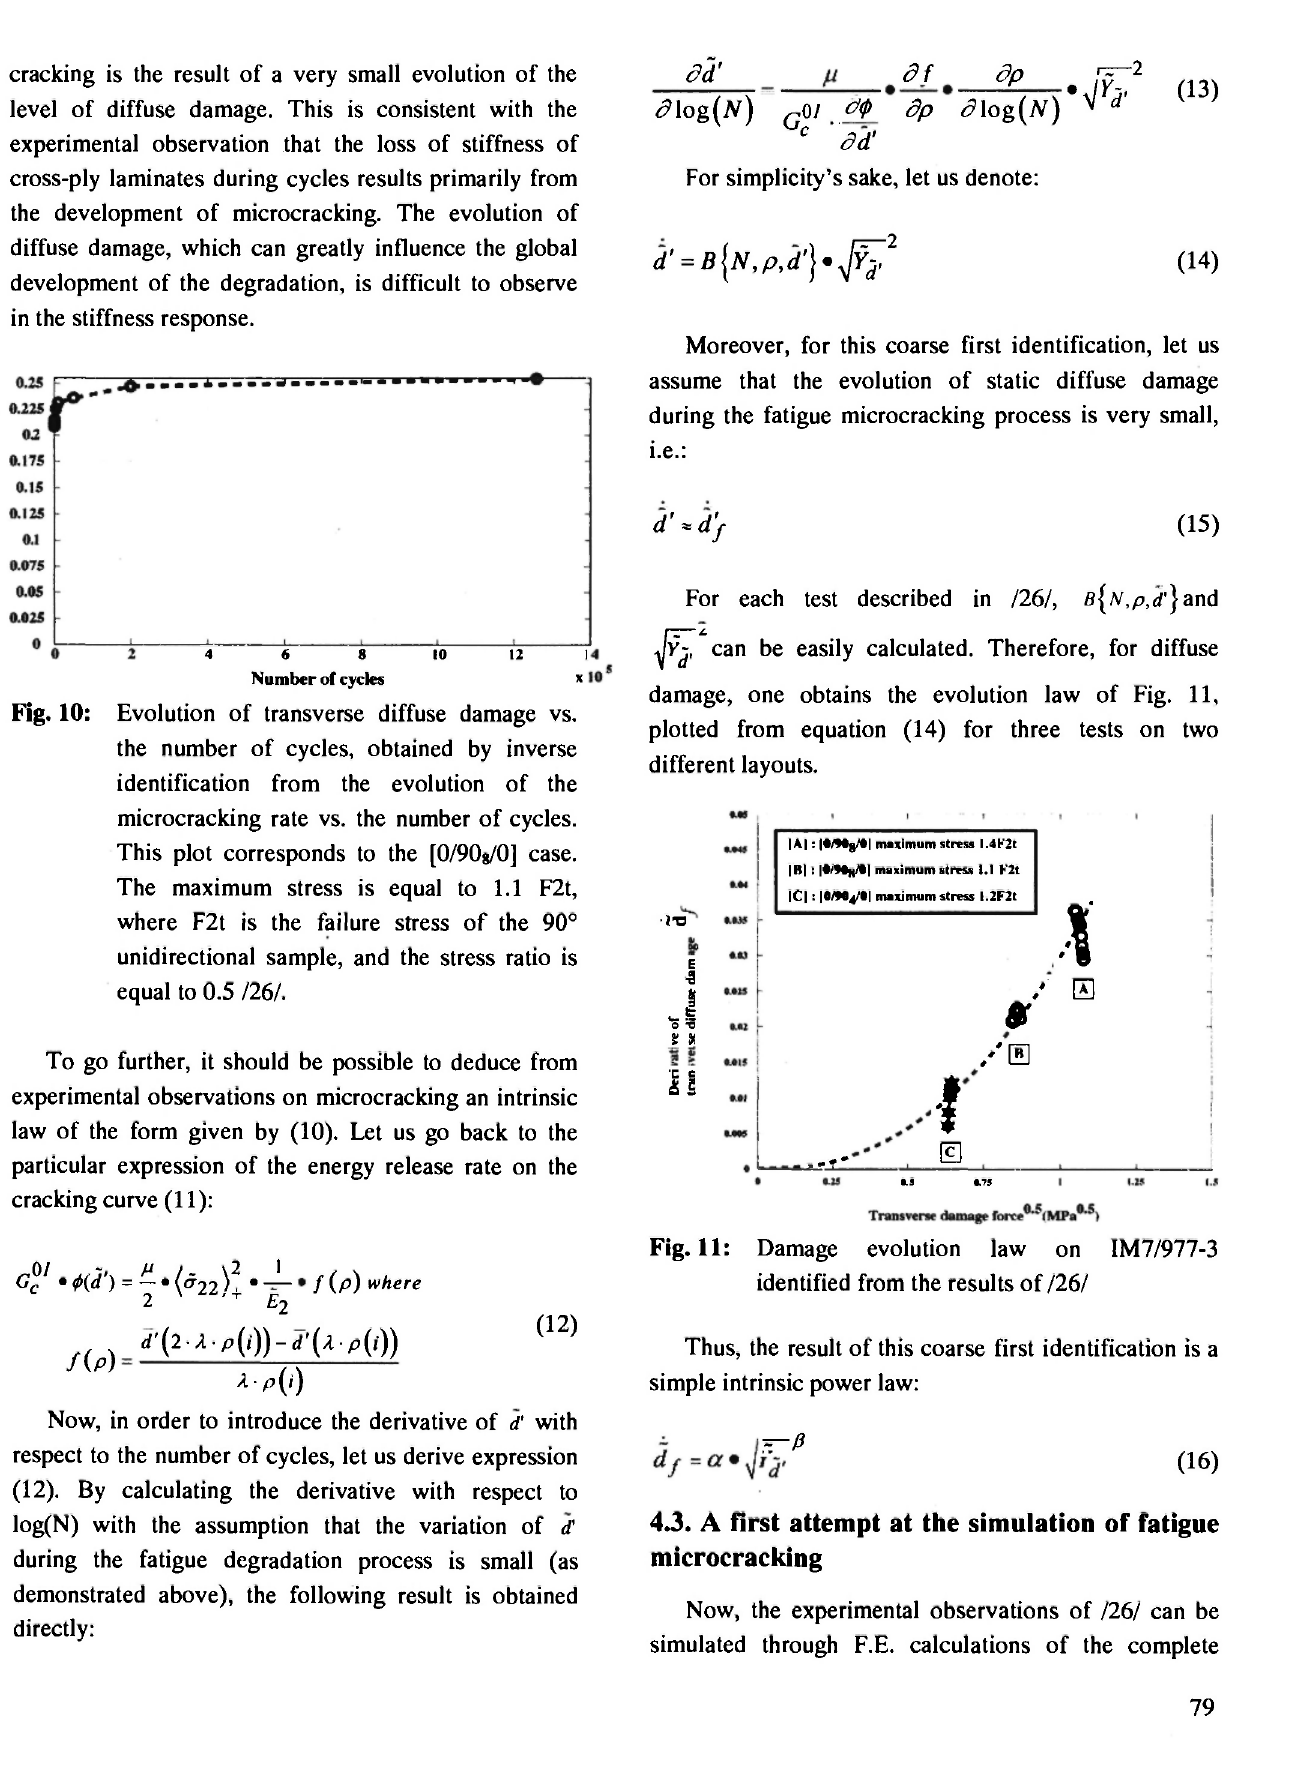
Fig. 10: Evolution of transverse diffuse damage vs. the number of cycles, obtained by inverse identification from the evolution of the microcracking rate vs. the number of cycles. This plot corresponds to the [0/90g/0] case. The maximum stress is equal to 1.1 F2t, where F2t is the failure stress of the 90° unidirectional sample, and the stress ratio is equal to 0.5 /26/.